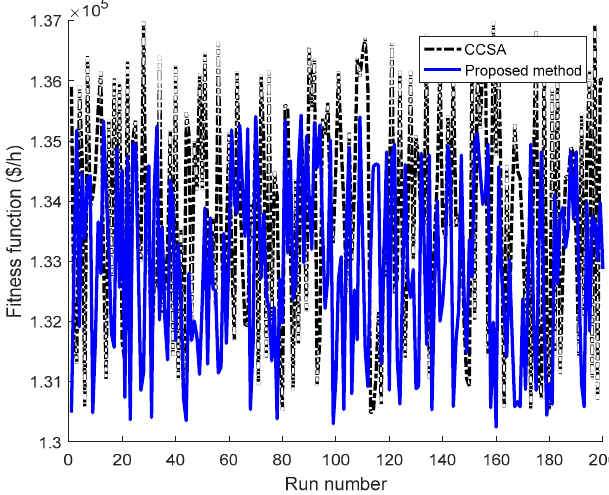
Figure 11. Fitness function of 100 runs obtained by the CCSA and proposed method in case 5. Table 10. The result comparison for case 5.